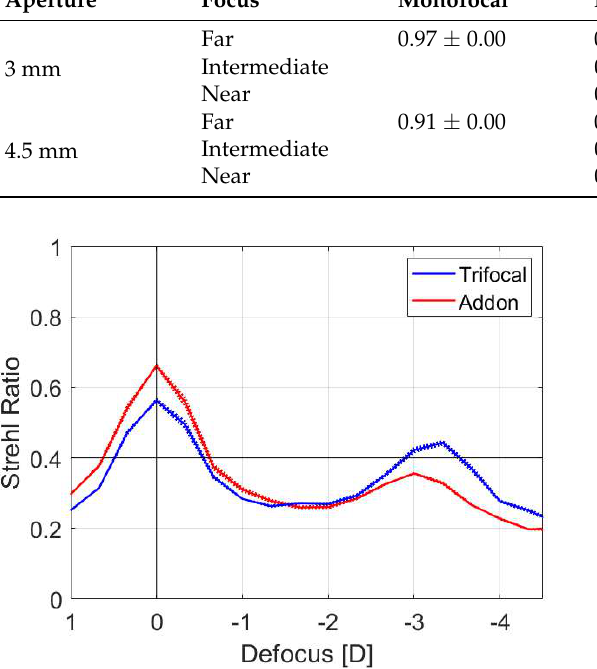
Table 1. Strehl ratio values of the analyzed lenses measured at the best far, near and intermediate focus. Figure 2. The modulation transfer function (MTF) of the monofocal, and single-lens trifocal and Aperture Mono-AddOn measured at a 3 and 4.5 mm pupil. The dotted lines show the values of each lens separately, the solid lines refer to the average of two IOLs.